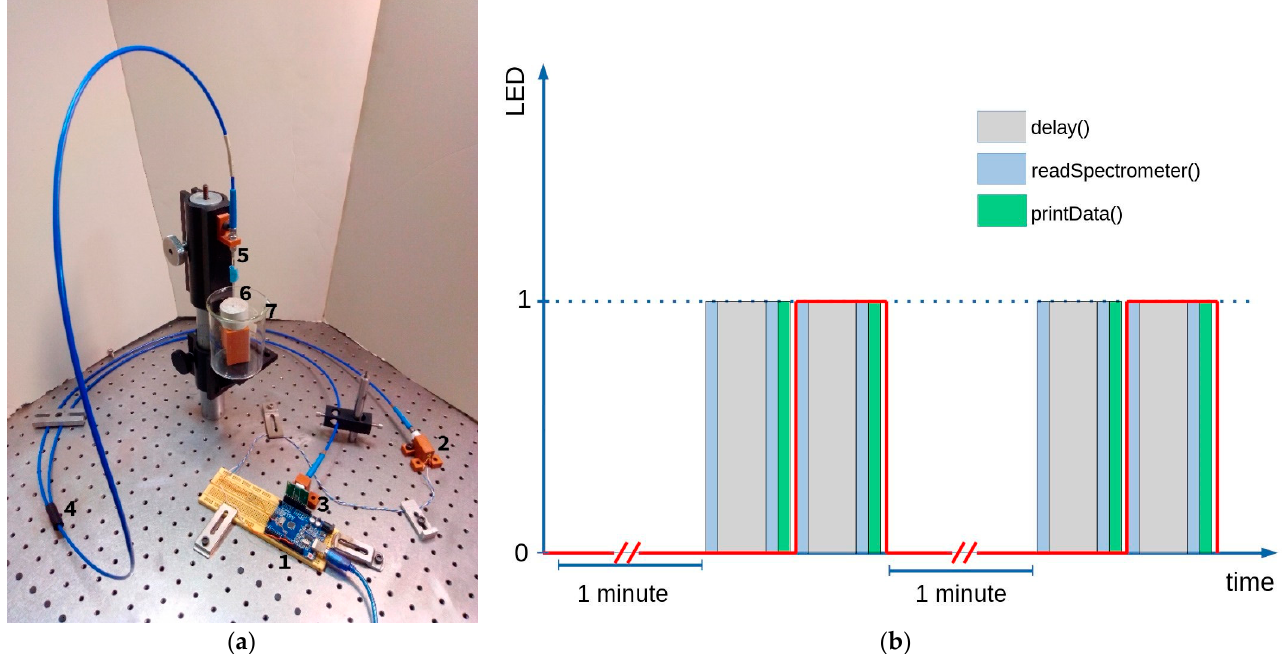
Figure 2. ( a ) Experimental setup for the monitoring of the cure and capillary coefficient of cement used during this work with a (1) microcontroller, (2) LED, (3) spectrometer, (4) 200 μ m multimode fiber bundle, (5) sensing 600 μ m multimode optical fiber, (6) cement paste sample and (7) recipient with water. ( b ) Graphical display of the MCU code, with one-minute pauses between readings, the sensor is reset by reading its stored values, followed by the integration time, e.g., a 200-millisecond delay, for the dark spectrum and the reflected light spectrum, which are measured and sent to a computer via UART.